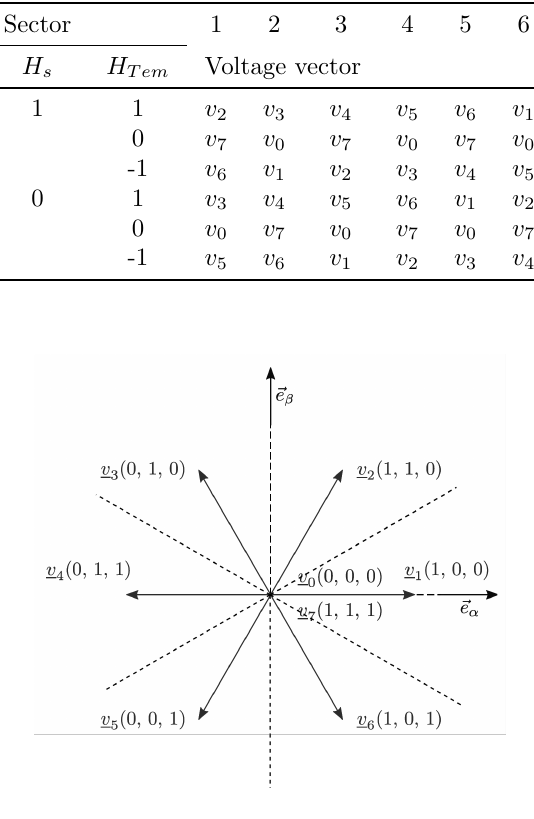
Fig. 8: Space vectors of the inverter output voltage and sectors. Figure 6: Voltage vector in the ( α , β ) plane (Begh and Herzog,